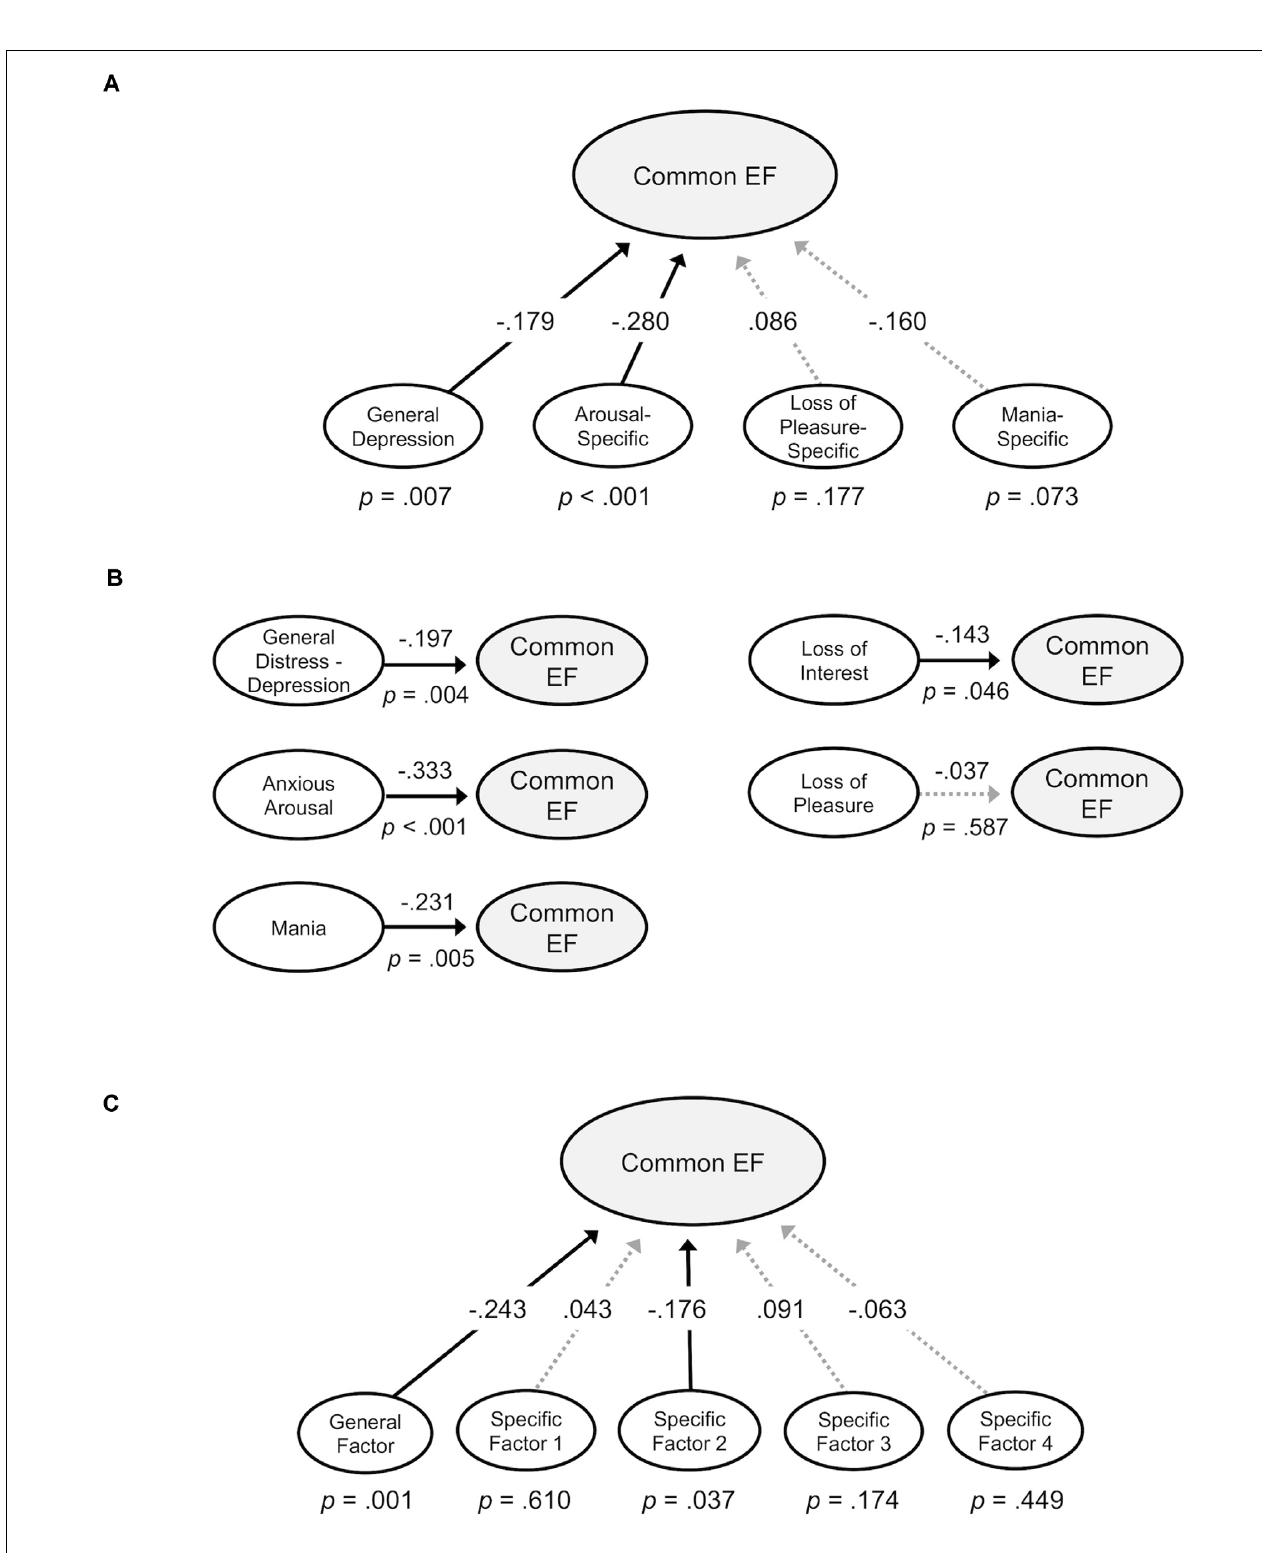
FIGURE 5 | Structural models examining associations between Common EF and symptom factors. Standardized estimates shown. Significant paths are shown in solid lines; non-significant paths are shown in lighter dotted lines. (A) Common EF regressed on general depression, arousal-specific, loss of pleasure-specific, and mania-specific factors from a confirmatory bifactor model. (B) Common EF regressed on general distress—depression, anxious arousal, loss of pleasure, loss of interest, and mania factors from standalone models. (C) Common EF regressed on general and specific factors from an exploratory bifactor model.